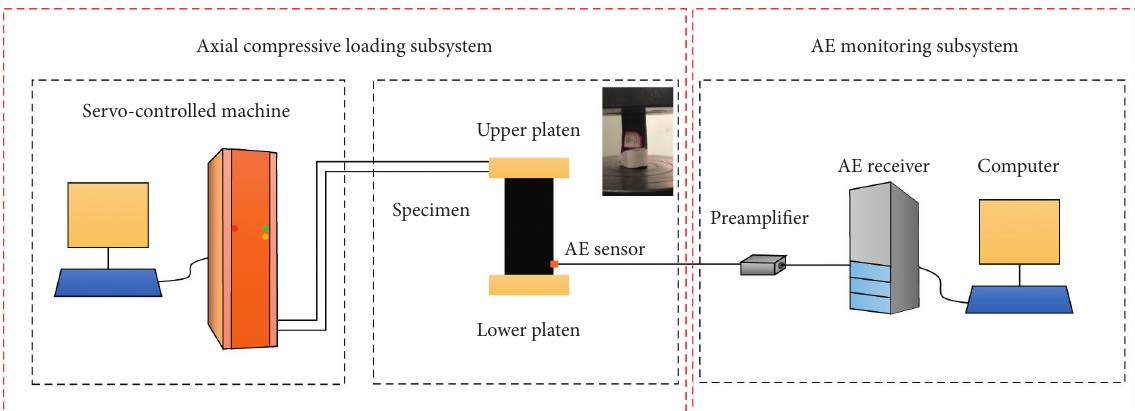
Figure 3: Schematic diagram of the test